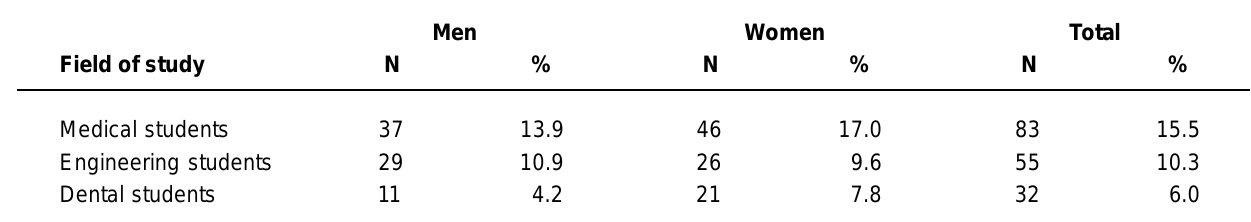
TABLE 4- Number and percentage of subjects scoring 15 or more on the modified dental anxiety scale according to gender and field of Men